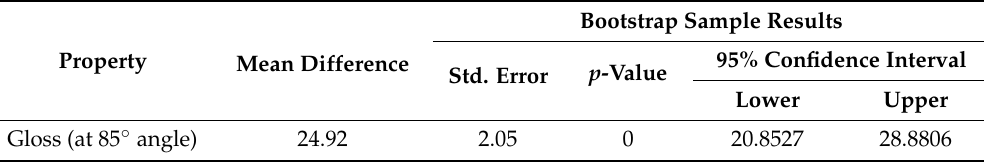
Table 7. Gloss test analysis results.